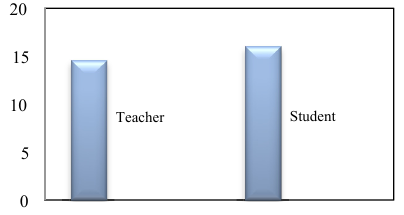
Figure 8. Average assessment of the rubrics of teachers and